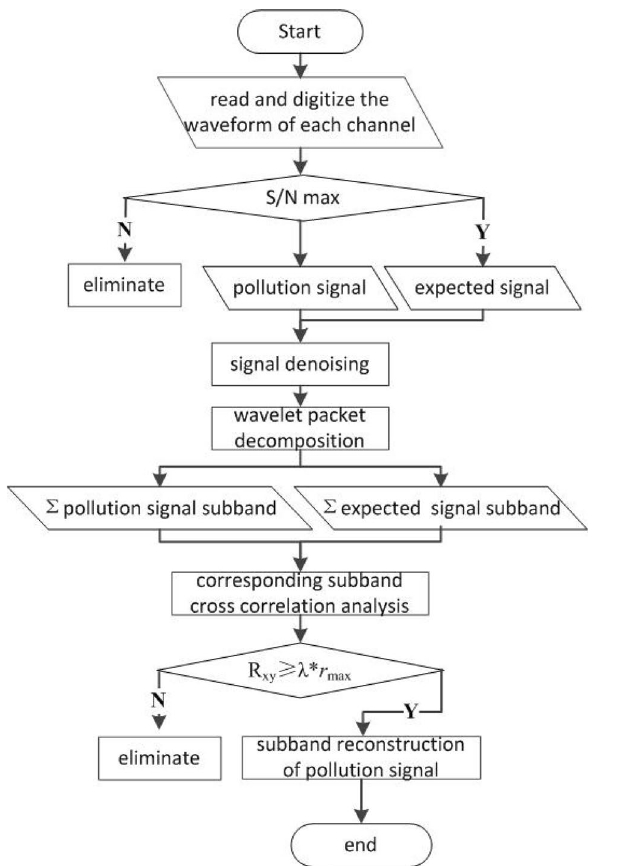
Figure 3. Flowchart for adaptive